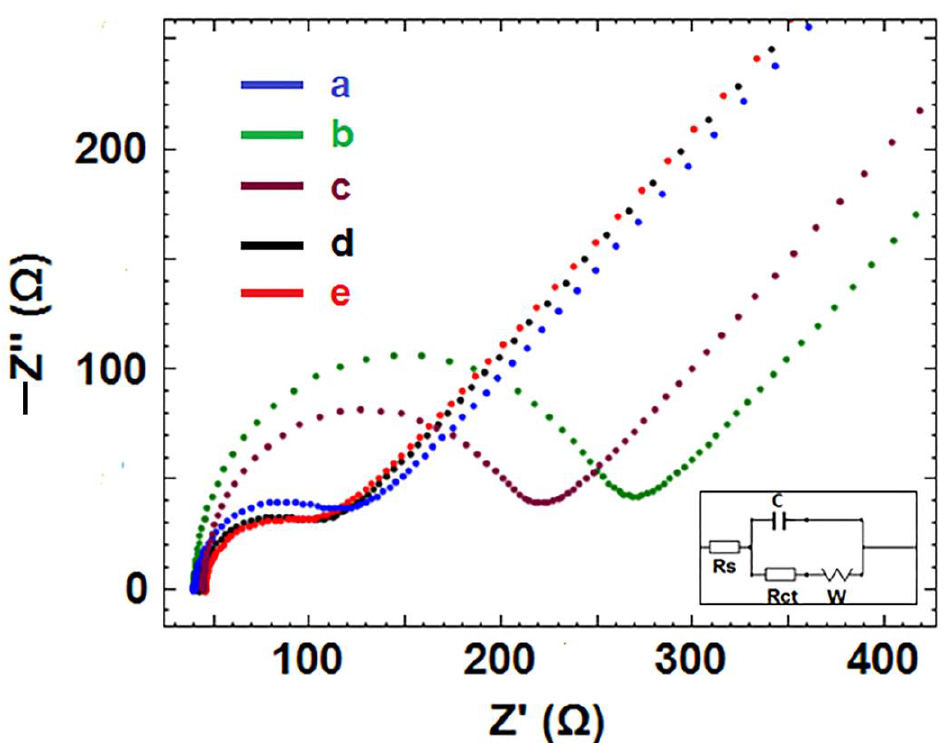
Figure 3. Simple equivalent circuit model in accordance with the Nyquist diagrams and impedance data obtained from the measurements performed with (a) PGE, (b) PGE (control), (c) CNF/PGE, (d) IL/PGE, (e) CNF - IL/PGE.